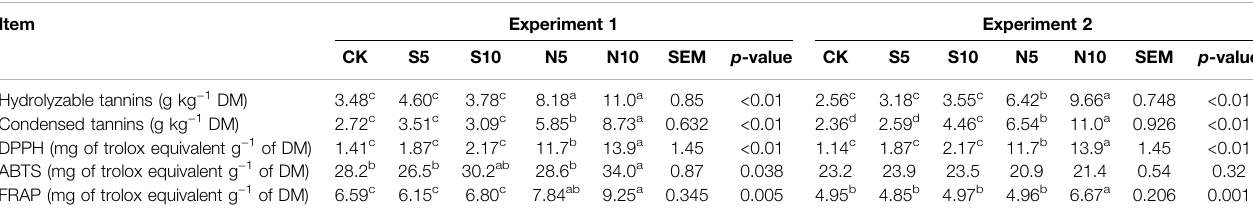
TABLE 4 | Tannin contents and antioxidant activities of stylo silage ( n =